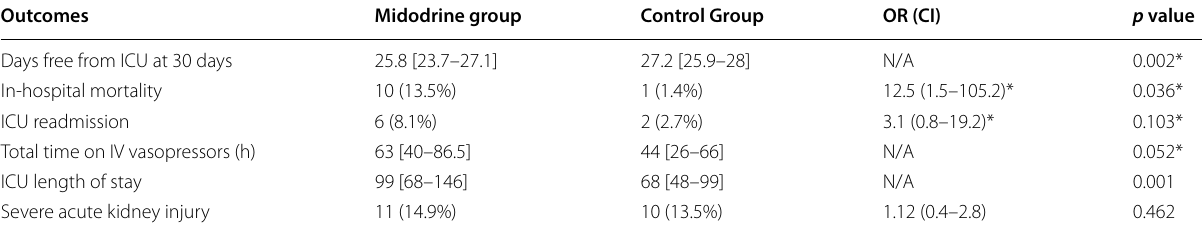
* Odds ratios and p values were computed after controlling for Euroscore II, cardiopulmonary bypass duration and propensity score, in binomial logistic, linear and Cox regression. Severe acute kidney injury: